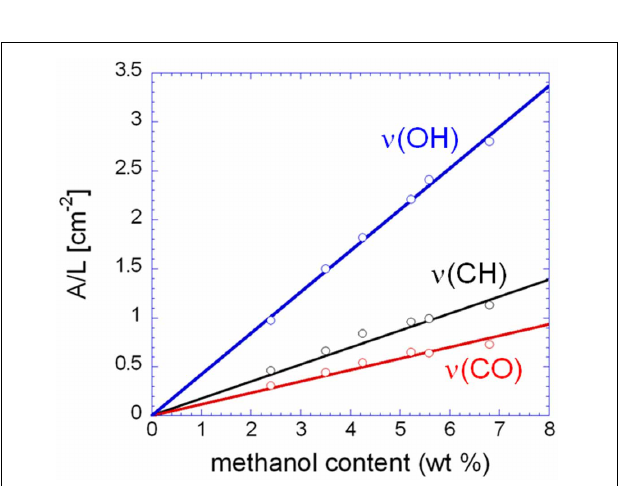
Figure 5 | (A) The Absorbance spectra in the ν (C = O) frequency range (1810–1640cm − 1 ) collected on polyimide film equilibrated at different vapor pressures of methanol; (B) difference spectra (equilibrated sample–dry